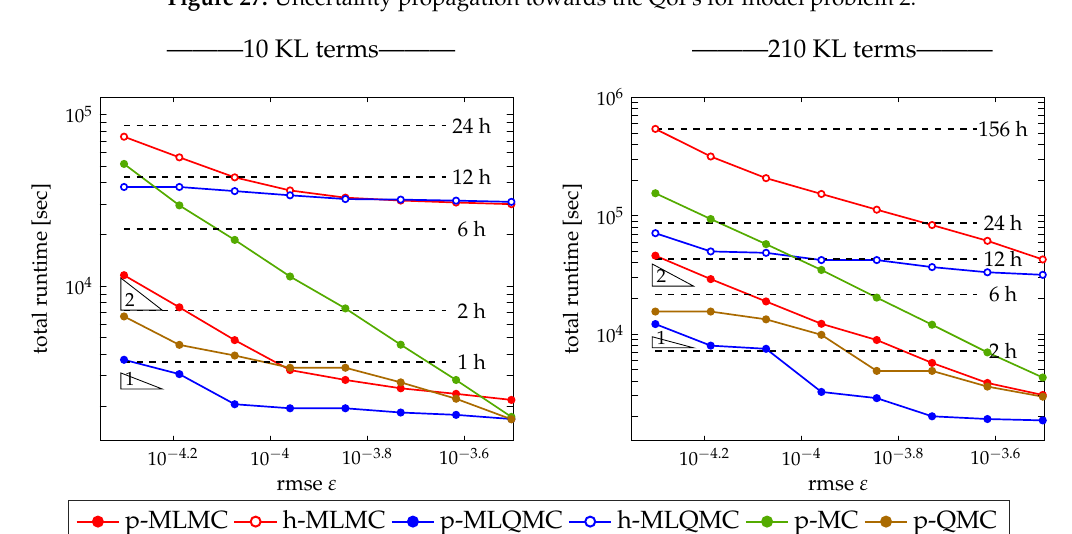
Figure 28. Runtimes for the different method in function of requested user tolerance for model problem 2.